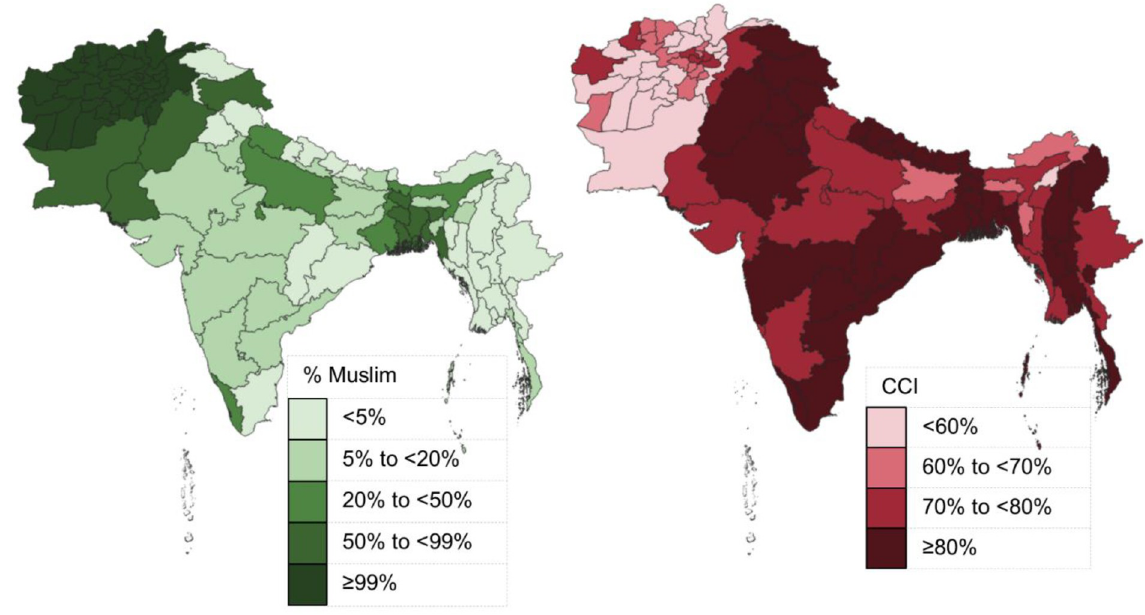
Fig 1. Choropleth maps of the proportion Muslim and the mean composite coverage index (CCI) across regions in 7 South Asian countries. Made with Natural Earth naturalearthdata.com.